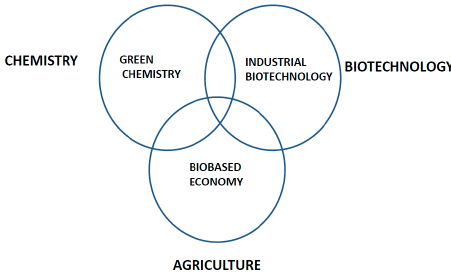
Figure 1. Intersections of fields involved in green processes (adapted from Map of knowledge by Jesper Sjöström—Greenchem Project) [6].Copyright year 2006 Publisher: Royal Society of